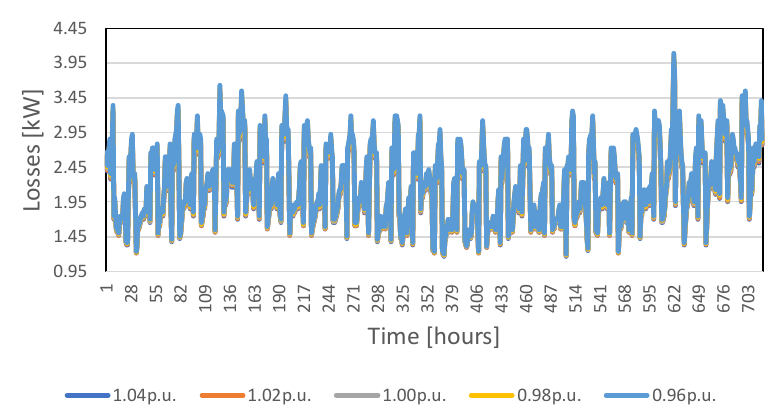
Figure 5. Total downstream losses in June for different conservation voltage reduction (CVR) setpoints on an hourly basis.